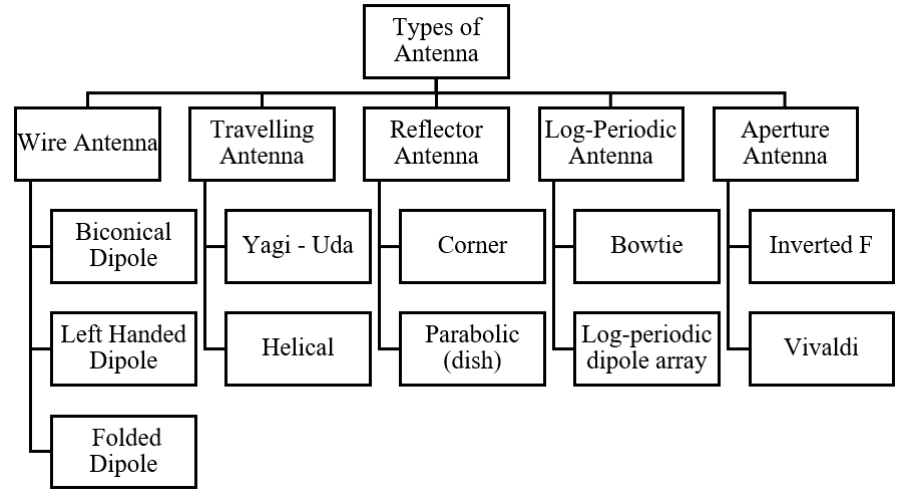
Figure 3. The major types of antenna